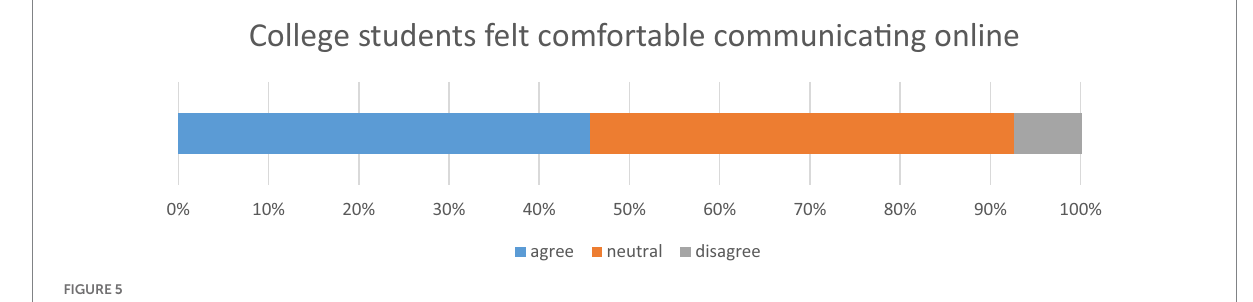
FIGURE 5 Distributions of whether user feel comfortable without voice or video during a virtual conference